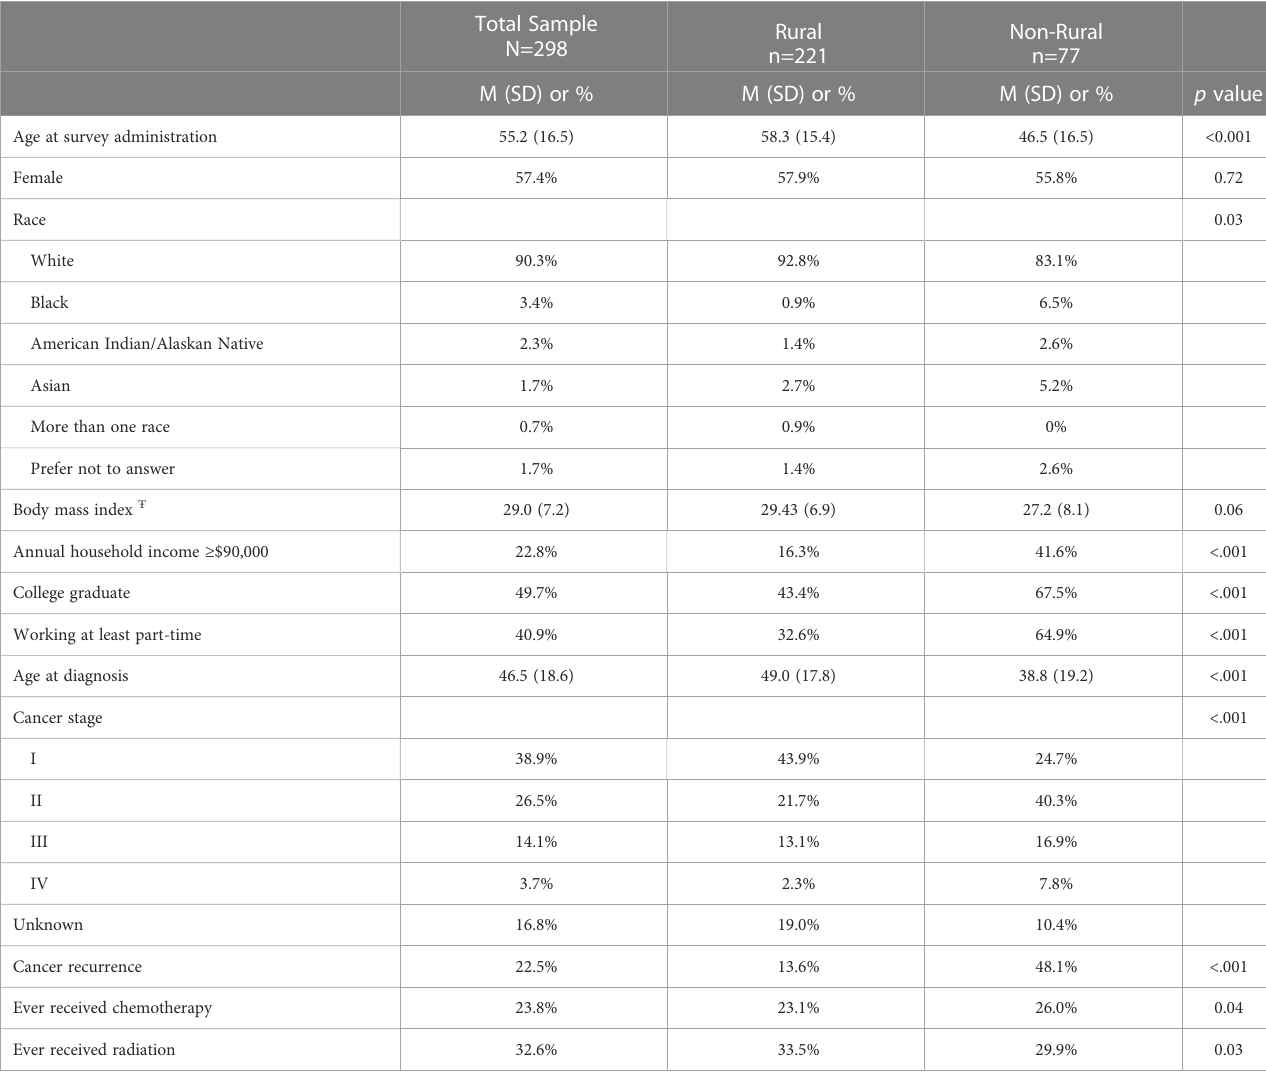
TABLE 1 Participant